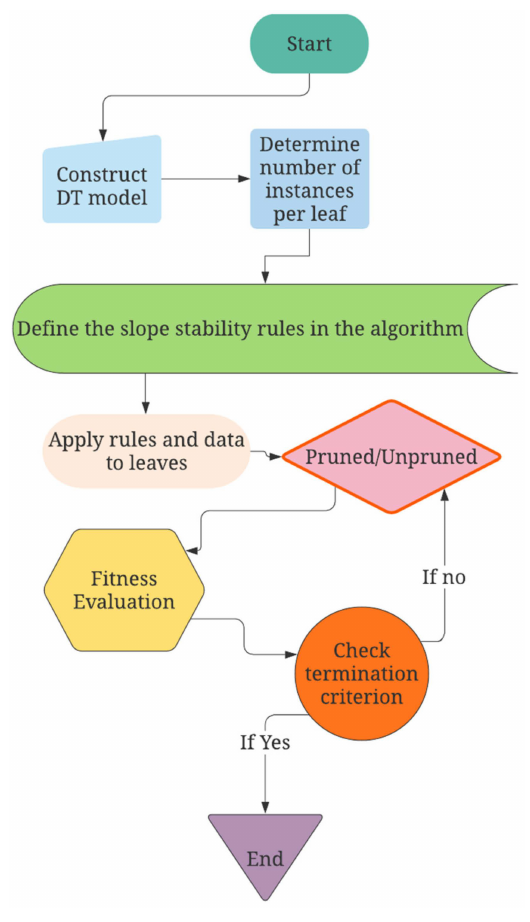
Figure 3. Methodology flowchart for DT